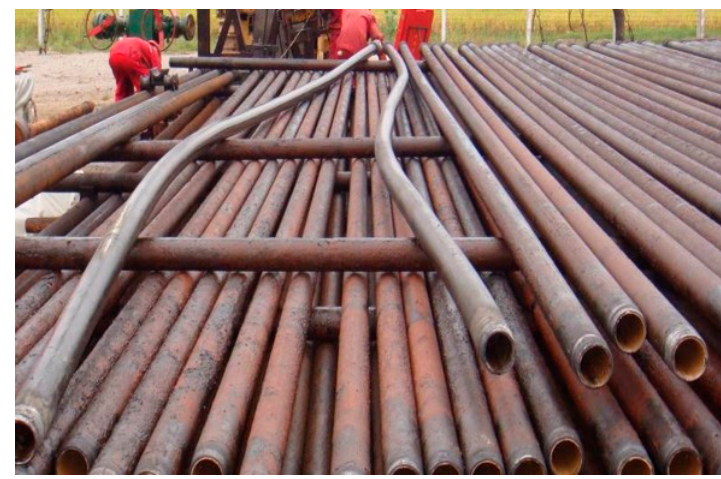
Figure 2. Schematic view of the salt cavern underground energy storage application. Fresh water or light brine is injected into the inner tubing, and high-concentration brine is expelled through the annular space in between the inner and outer tubings. This process is known as direct circulation, as distinguished from reverse circulation. Direct and reverse circulations are alternately employed until the salt cavern achieves the design shape and dimensions.